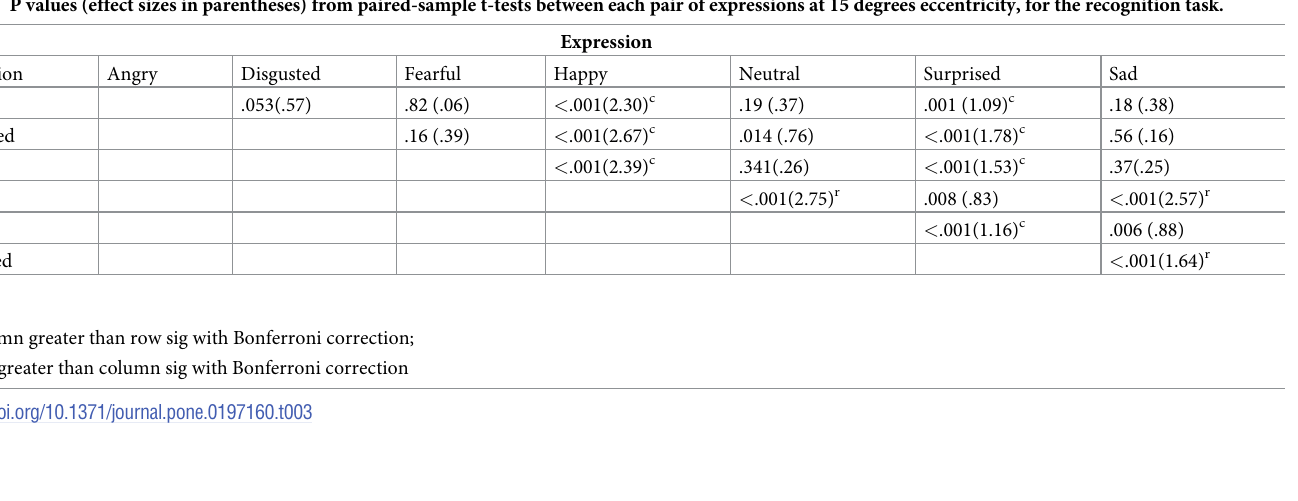
Table 3. P values (effect sizes in parentheses) from paired-sample t-tests between each pair of expressions at 15 degrees eccentricity, for the recognition